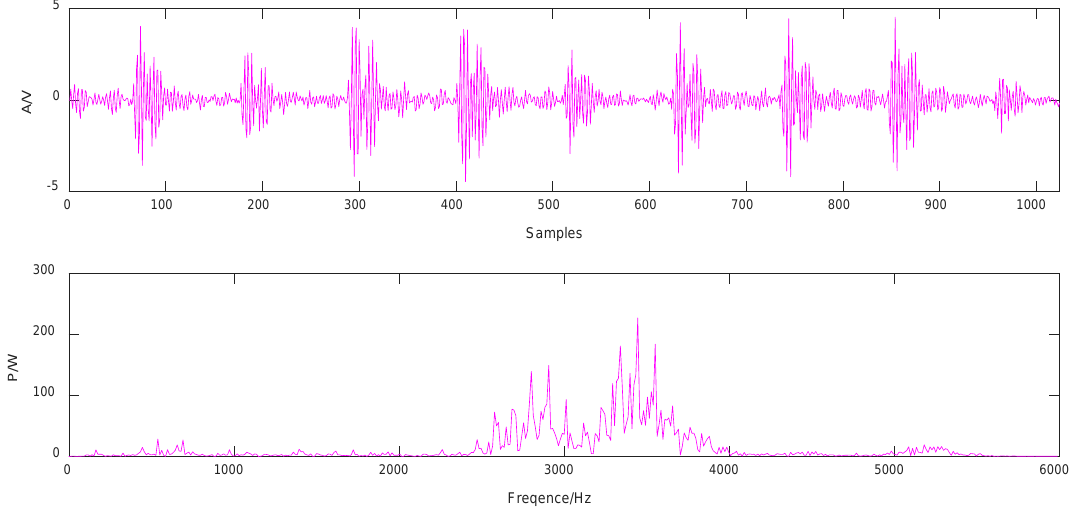
Figure 9. Fault operation signal and spectrum of bearing outer ring.